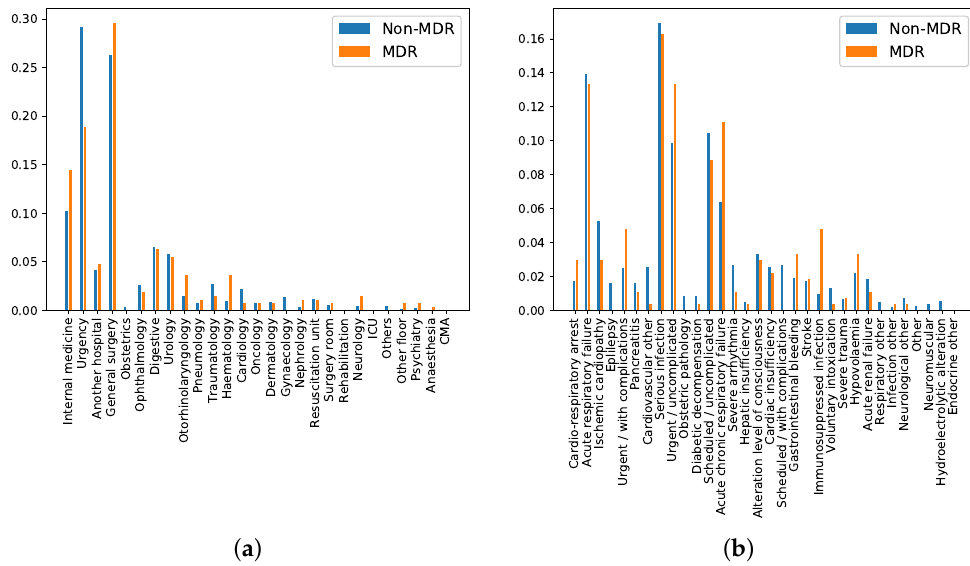
Figure 5. ( a ) Rate of episodes for each department of origin , normalized for non-MDR and MDR patient episodes; ( b ) rate of episodes for each reason of admission , normalized for non-MDR and MDR patient